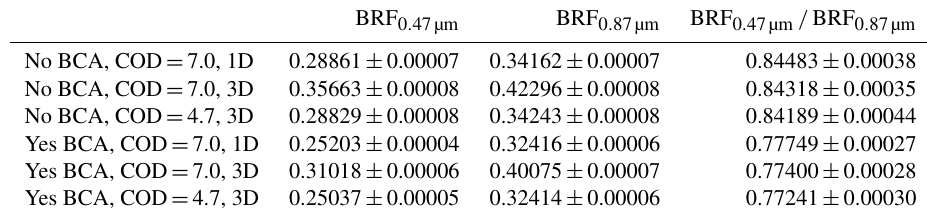
Figure 10. Retrieved cloud optical depth. Pixels without valid retrievals are shaded white. Table 5. Simulated CAR BRFs at the center of a hypothetical